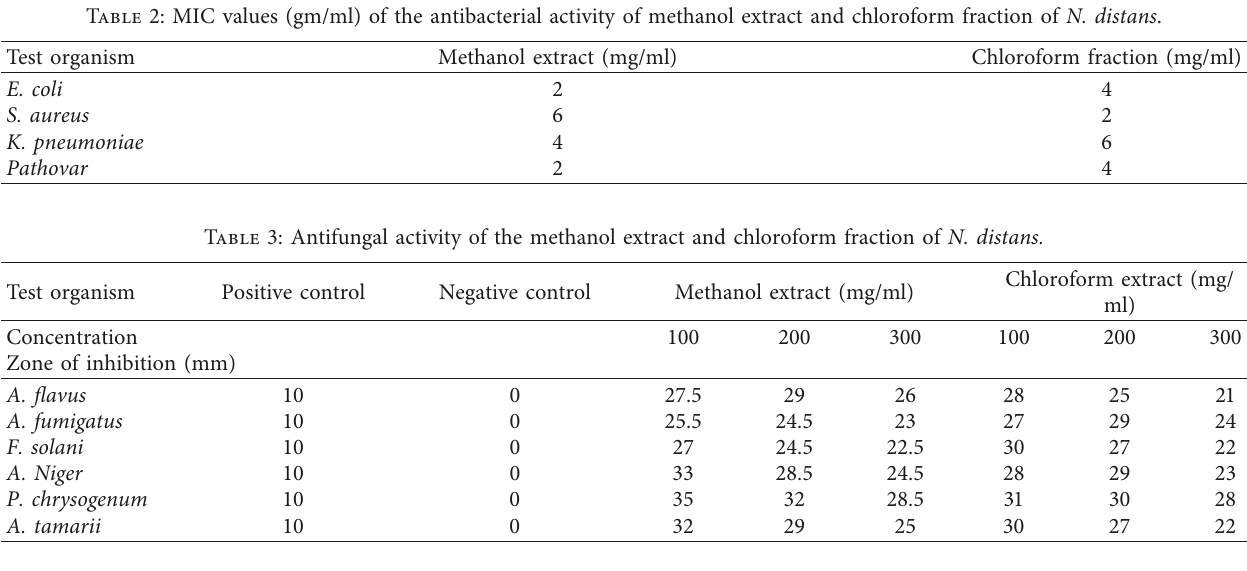
Table 4: MIC values (gm/ml) of the antifungal activity of the